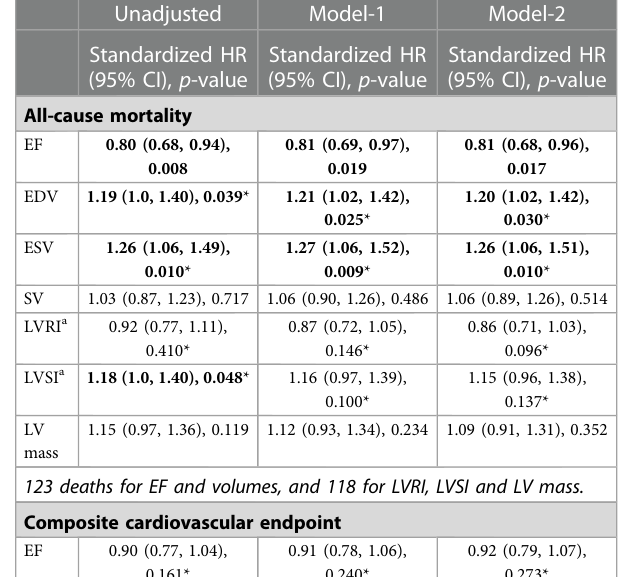
TABLE 2 Associations between 3DE LV measures and outcomes in the overall population (imputed data). Unadjusted Model-1